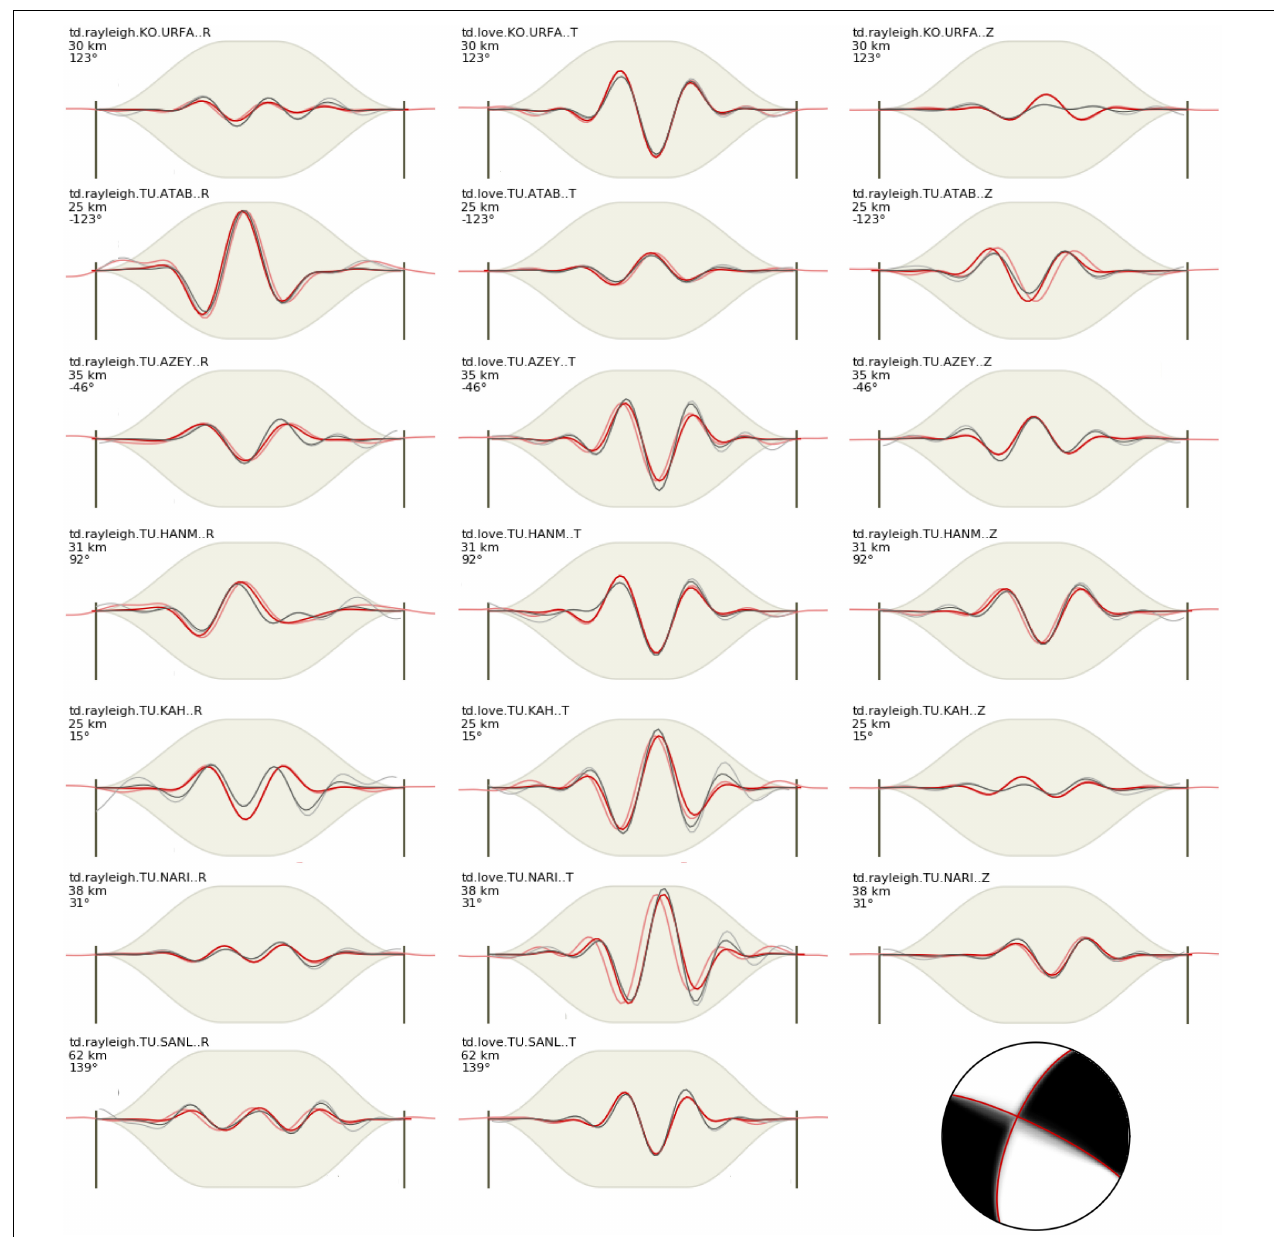
FIGURE 5 | Waveform fits in the time domain for the 2017-08-31 (UTC) 16:11:09 M 3.1 earthquake. Red and gray waveforms represent synthetic and observed records, respectively. The fuzzy MT shows the solution with its uncertainties (see also Supplementary Figures 6 , 7